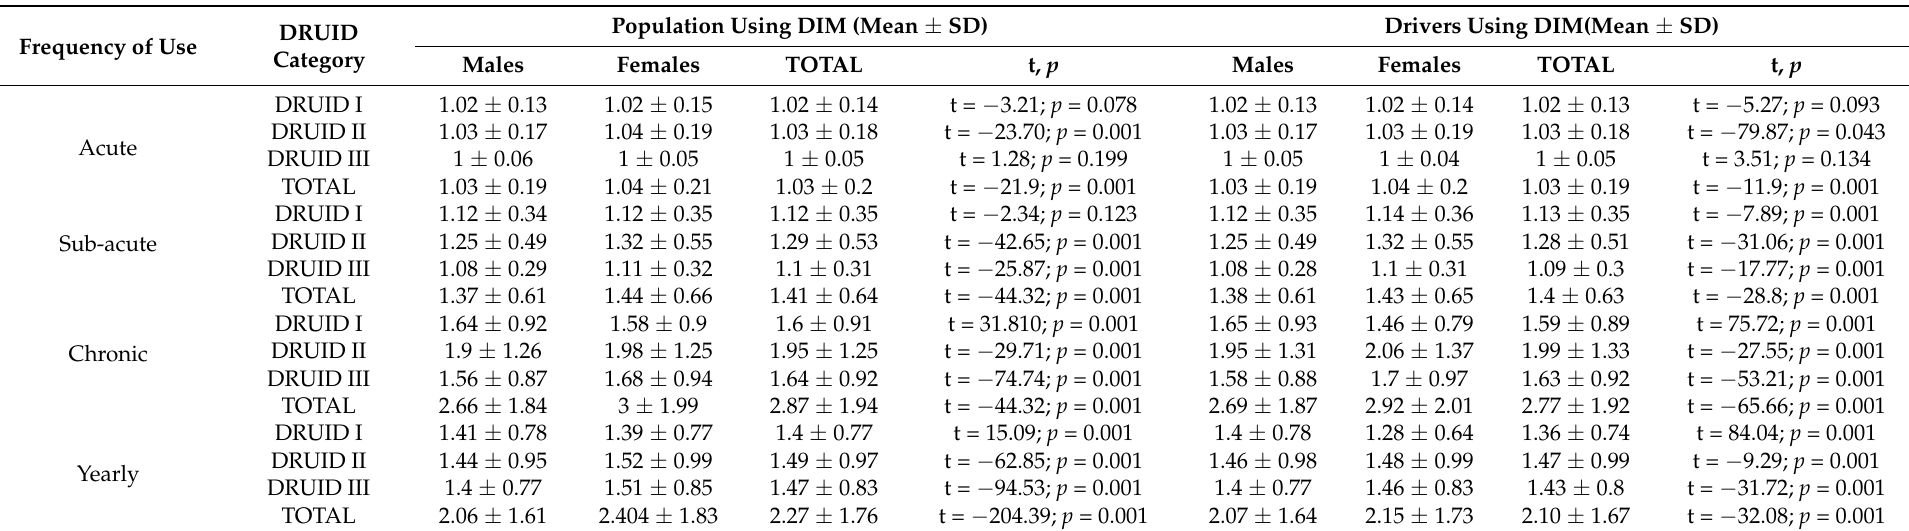
Table 3. Average DIMs consumed in Castile and Leon by frequency of